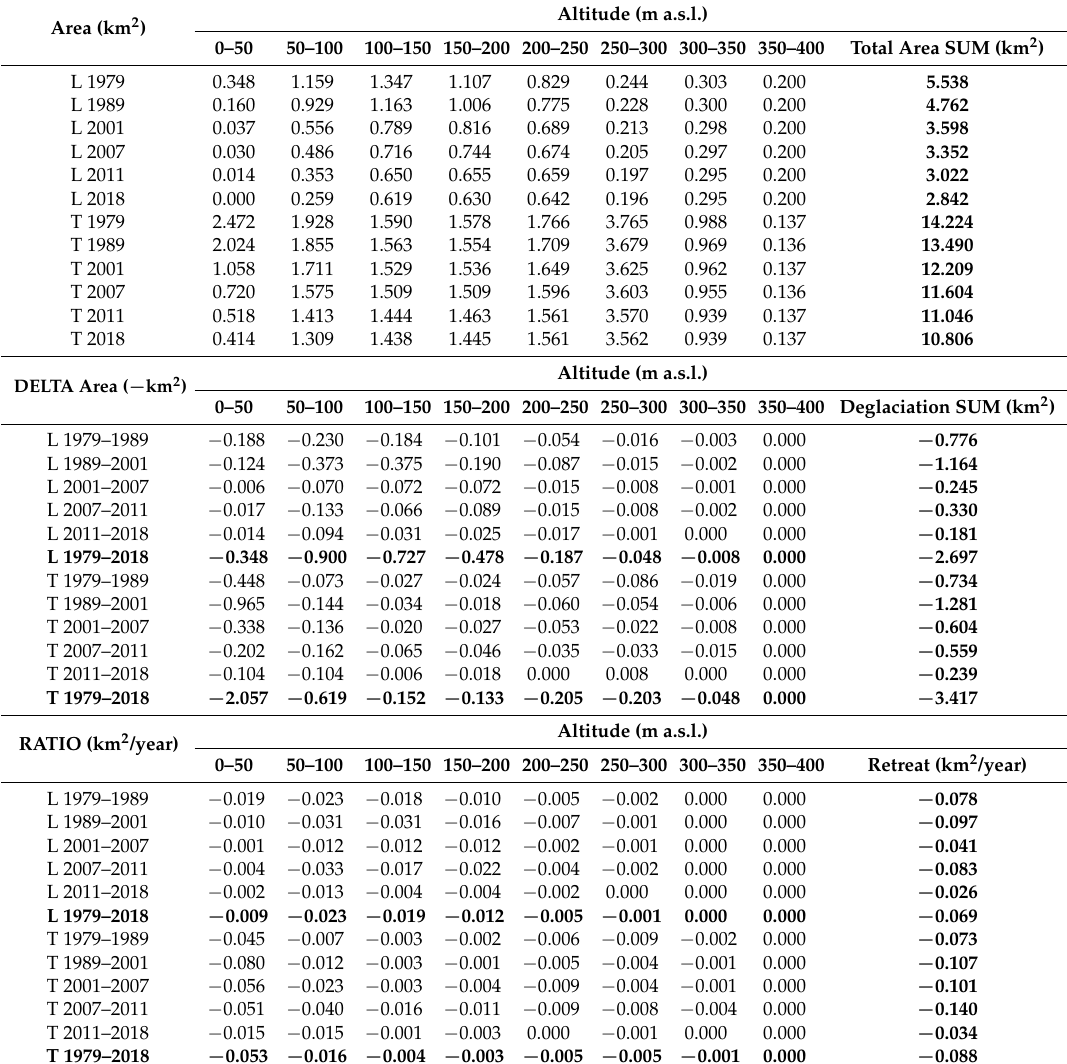
Table A1. The change in the glaciated area and ratio of the glaciated area loss for 1979–1989, 1989–2001, 2001–2007, and 2007–2011 for land-terminating glaciers (L) and tidewater glacier (T) in ASPA-128. The sums and averages for each altitude interval, and the sums and averages for each of the analyzed periods are in